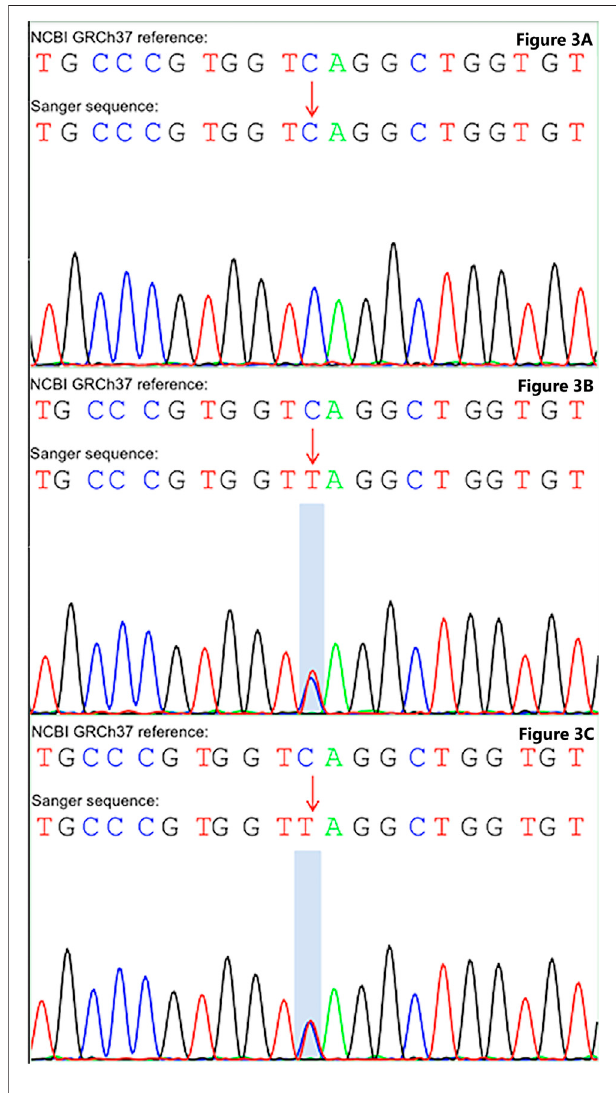
FIGURE 3 | Sanger sequencing unravel gene mutation in COL1A1. (A) Wild type was detected in the COL1A1: NM_000088: exon25: c.C1726T: p.Q576X without mutation in the father. (B) Heterozygous mutation in the COL1A1: NM_000088: exon25: c.C1726T: p.Q576X of the mother. (C) Heterozygous mutation in the COL1A1: NM_000088: exon25: c.C1726T: p.Q576X of the